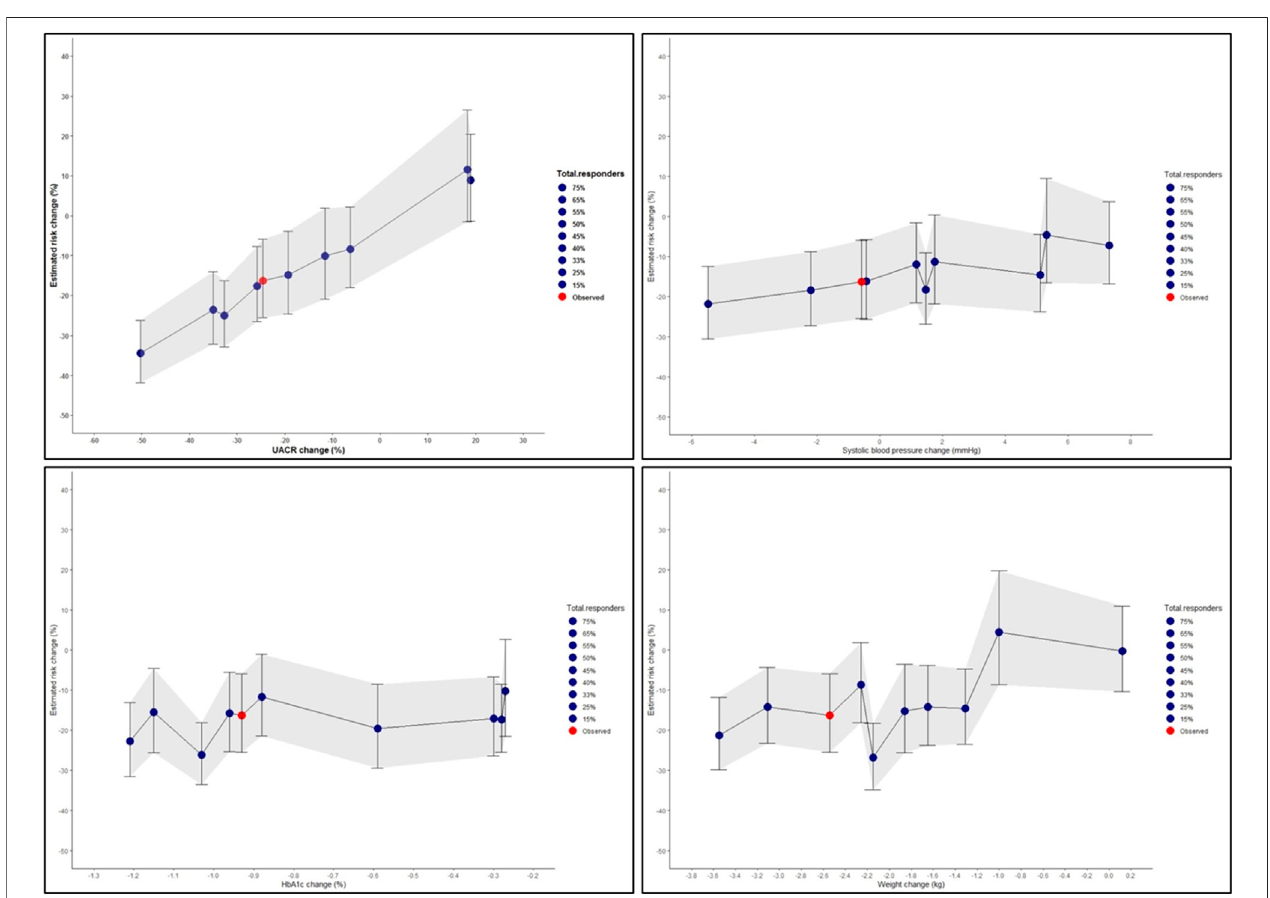
FIGURE 4 | Simulated risk marker changes and the effect on the composite kidney or cardiovascular death outcomes for the ongoing FLOW trial based on the selected LEADER trial population. The shaded area indicates the 95% con fi dence intervals for the simulated risk marker changes. Risk prediction was estimated from short-term risk marker changes in the FLOW population (N = 327) chosen from the LEADER trial, and simulated values for UACR, systolic blood pressure, HbA1c, and body weight. The red dot indicates the PRE score predicted risk change in the FLOW trial without enrichment with responders. The blue dots represent changes observed in the different proportion of responders and non-responders for each riskmarker. HbA1c, glycated hemoglobin; UACR, urinary-albumin-to-creatinine ratio.